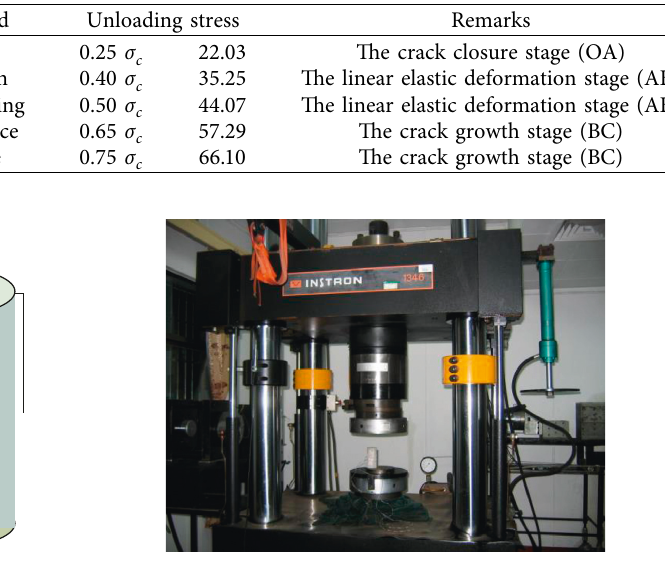
Table 3: List of pre-damaged specimens.